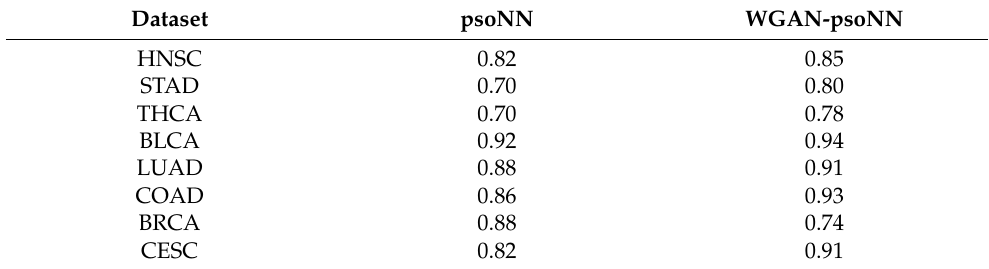
Table 3. Comparing the prediction accuracy of psoNN and WGAN-psoNN.